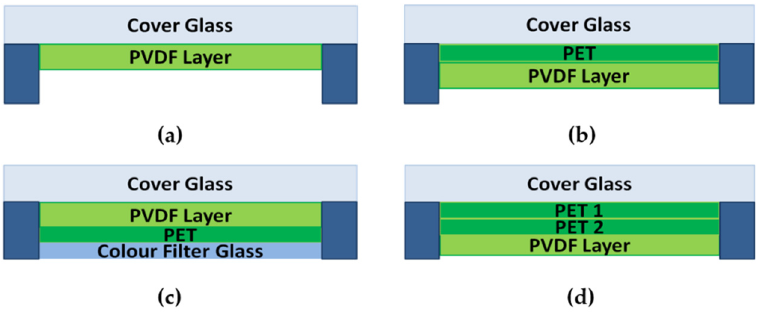
Figure 3. Four typical stack-ups of the piezoelectric touch panel: ( a – d ), the electrodes are on and underneath the piezoelectric film layer [42].